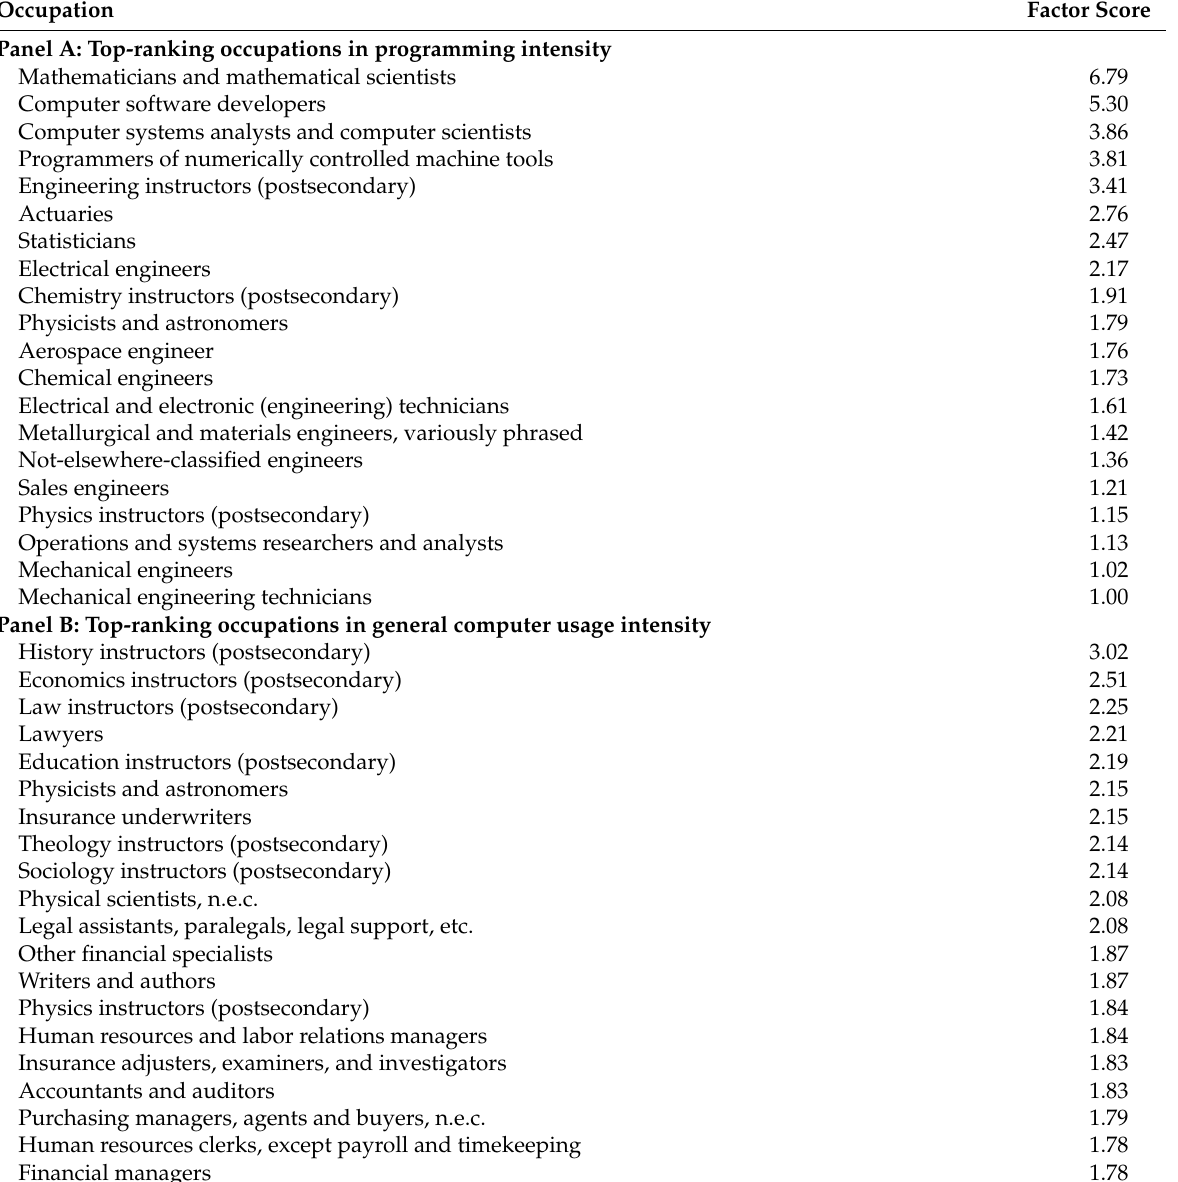
Table 1: Twenty highest ranked nonmanual occupations in programming intensity and general computer usage